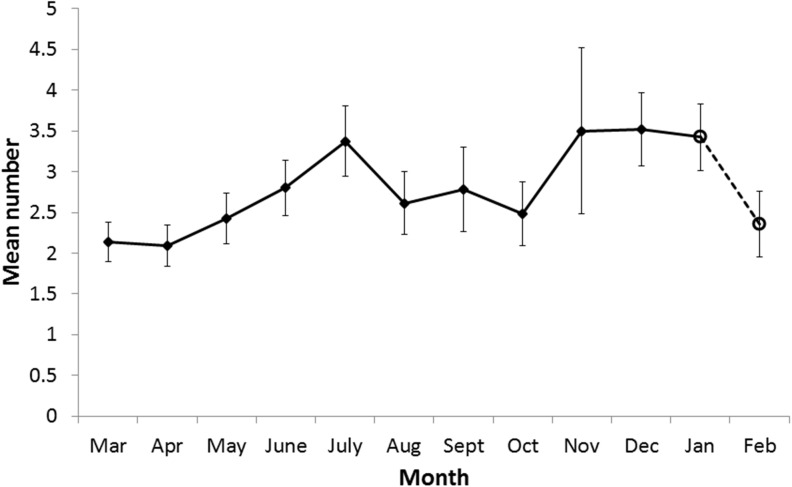
Mean number of corpora lutea in each month.The mean number of corpora lutea found in each month in females carrying blastocysts (diamond marker and solid line) or foetuses (open circular markers and broken line). Error bars depict standard error of the mean.